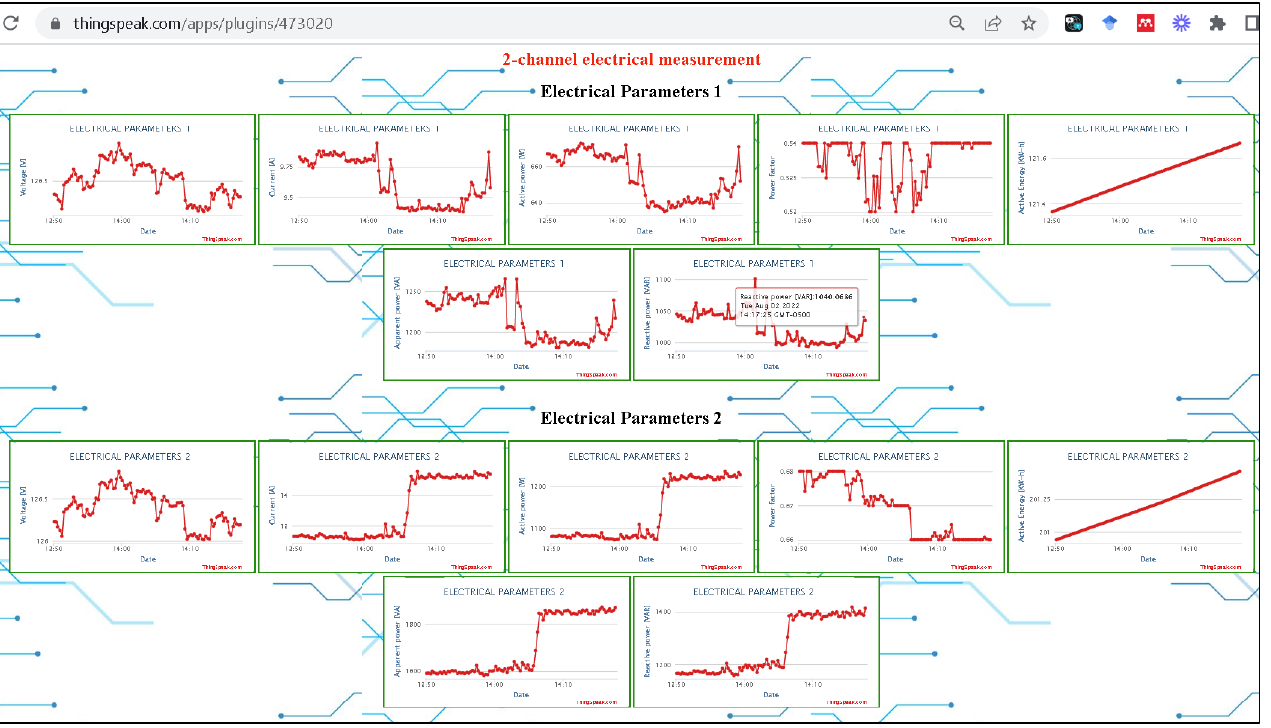
Figure 12. Screenshot of the web interface for remote monitoring of electrical parameters.